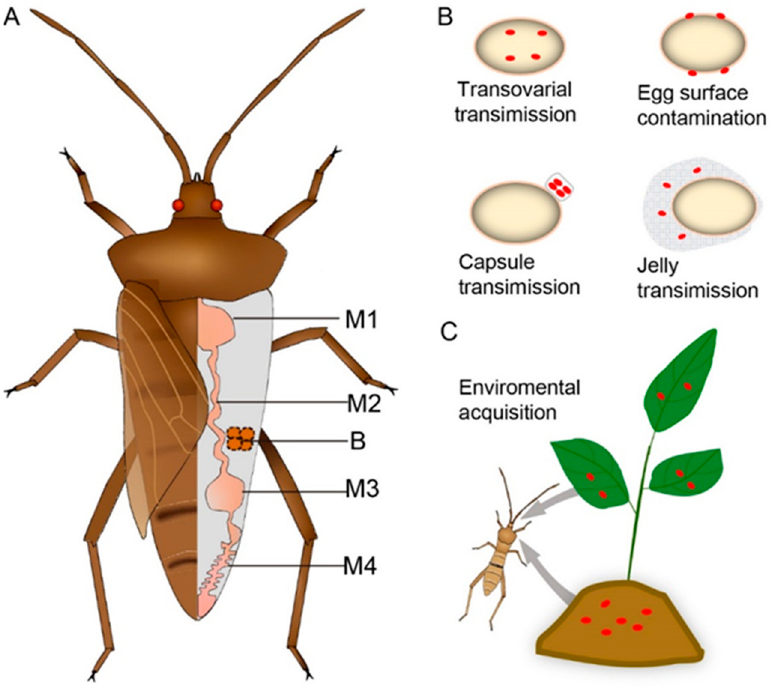
Figure 2. The main transmission routes of symbionts in stinkbugs. ( A ) schematic stinkbug with symbiotic tissues in an adult insect. M1, midgut first section; M2, midgut second section; M3, midgut third section; M4, midgut fourth section with crypts; B, bacteriomes, dotted line means that bacteriomes are absent in some species. ( B ) four distinct routes for the vertical transmission of symbionts during the egg stage; ( C ) the bacterial acquisition from soil or plant material during the nymph